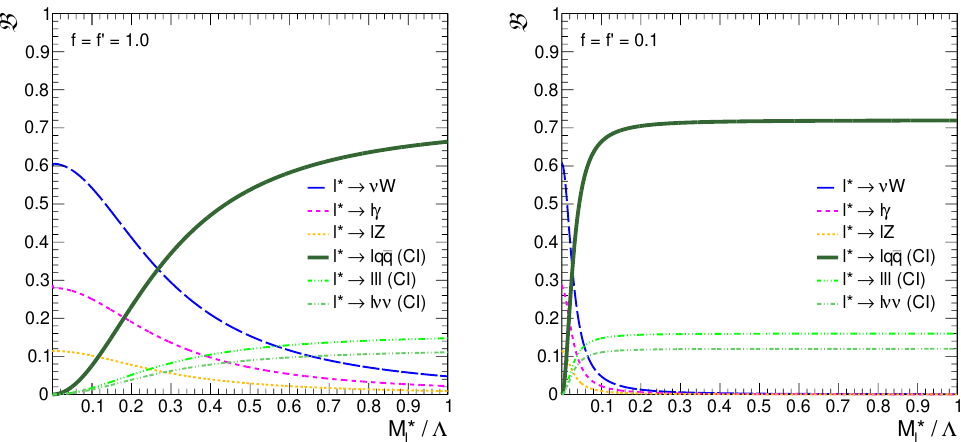
Figure 2 . Branching fractions, , of excited lepton decay channels as a function of the ratio of the B excited lepton mass ( M ) and compositeness scale ((cid:3)) for (cid:12)xed values of the model parameters ‘ (cid:3) f = f 0 , which represent the couplings of excited leptons to SM particles. The branching fraction calculation is based on ref. [6]. The contact interaction decay to one lepton and two jets, subject of this analysis, is dominating the region of high M /(cid:3). Couplings f and f 0 are assumed to be equal ‘ (cid:3) to 1 in the left graph, and 0.1 in the right